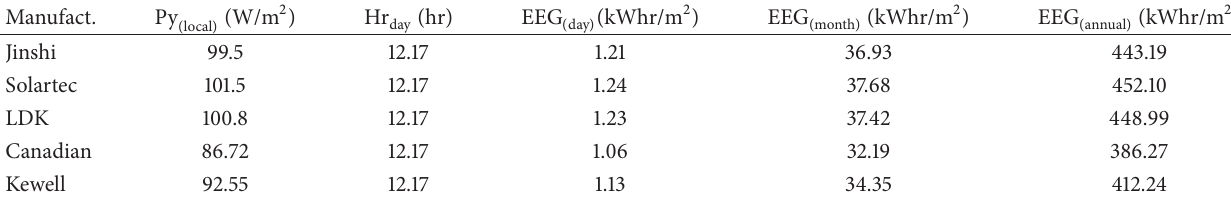
Table 5: EEG at Merida per day, month, and year.